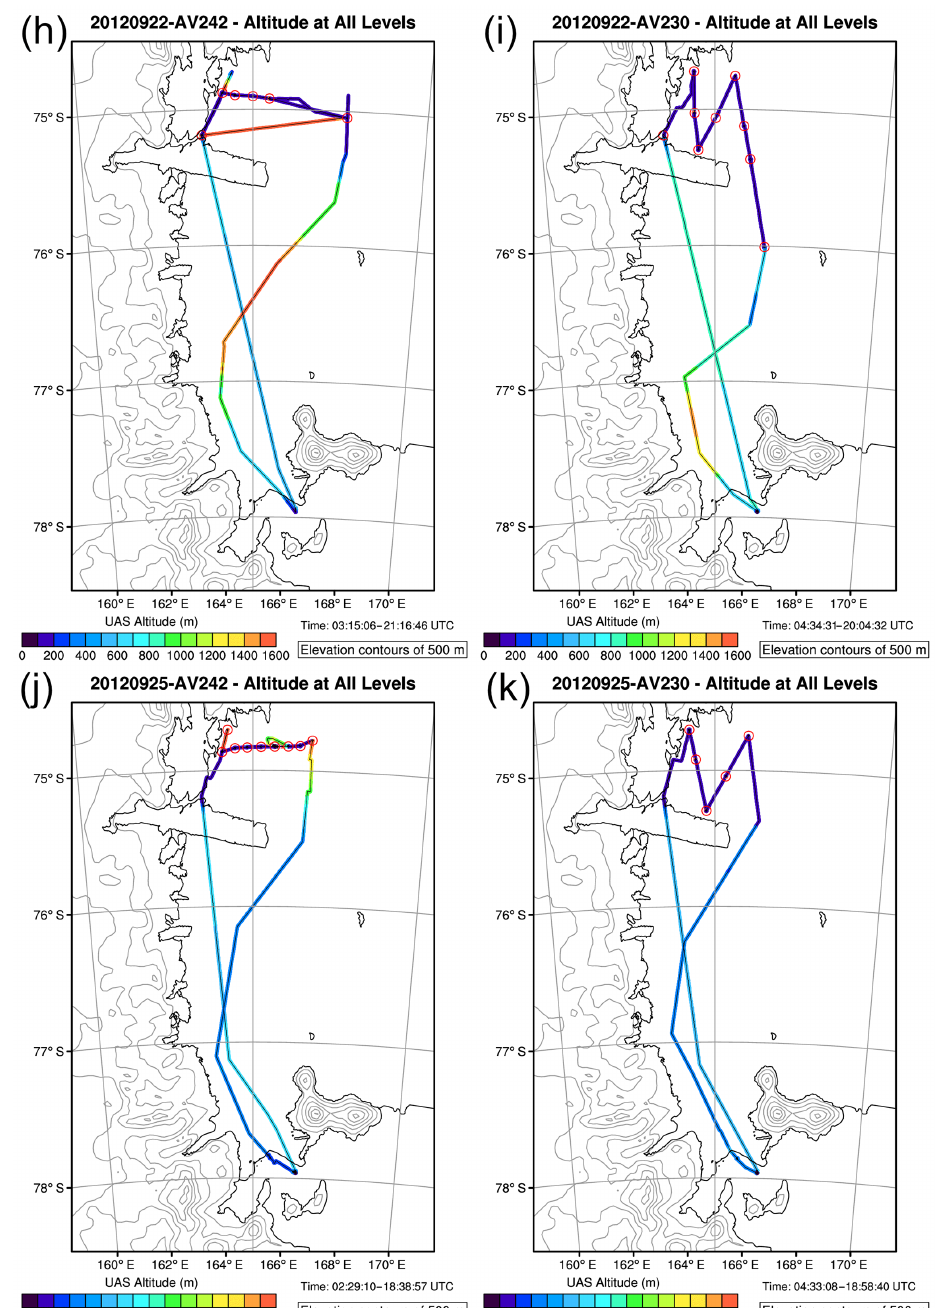
Figure 3. Maps of Terra Nova Bay flights on 13 September 2012 AV214 (a) , 14 September 2012 AV216 (b) and AV230 (c) , 18 Septem- ber 2012 AV215 (d) and AV230 (e) , 19 September 2012 AV215 (f) and AV242 (g) , 12 September 2012 AV242 (h) and AV230 (i) , and 25 September 2012 AV242 (j) and AV230 (k) . Color shading along flight path indicates flight altitude. Red circles indicate location of